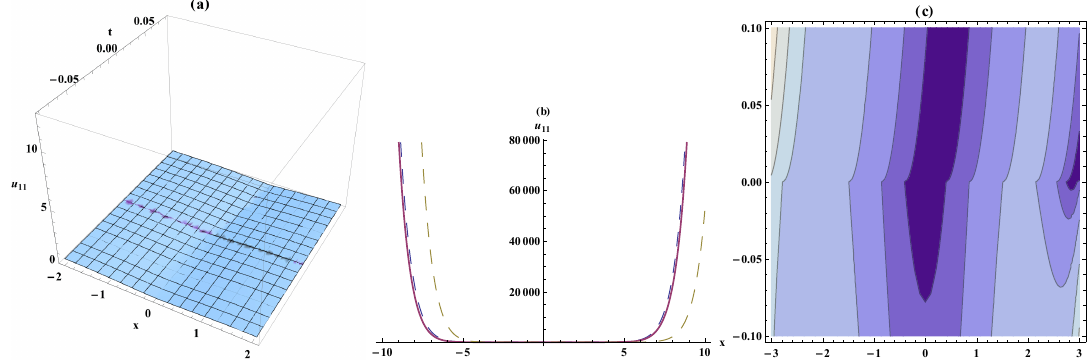
Figure 12. Solitary wave, the bistable wave amplitude, and contour plots for Equation (104). On the respective interval { x , − 2.05,2.05 } , { t , − 0.08,0.08 } , { x , − 10,10 } , { t , − 1,1 } , { x , − 3,3 } , { t , − 0.1,0.1 } .